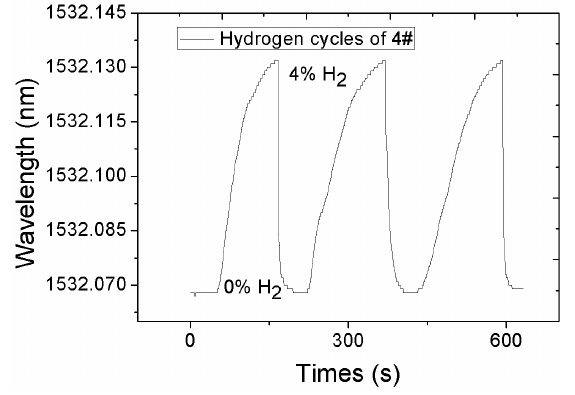
Figure 6. Response curve of composite-structured FBG to hydrogen.